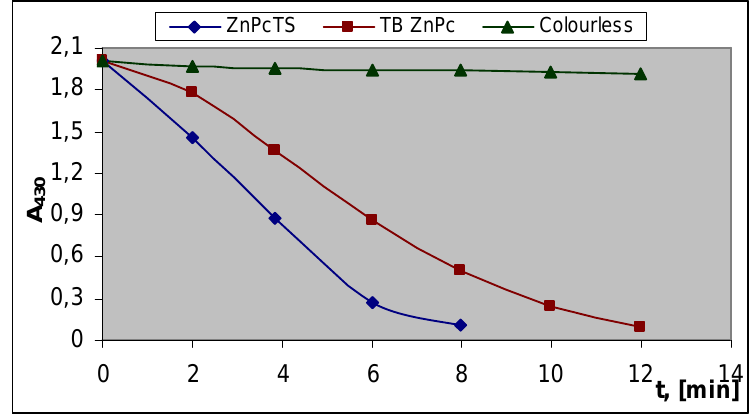
FIGURE 4 . Kinetic studies of the photobleaching of DPFB by TBZnPc and ZnPcTS conjugates suspended in DMF.